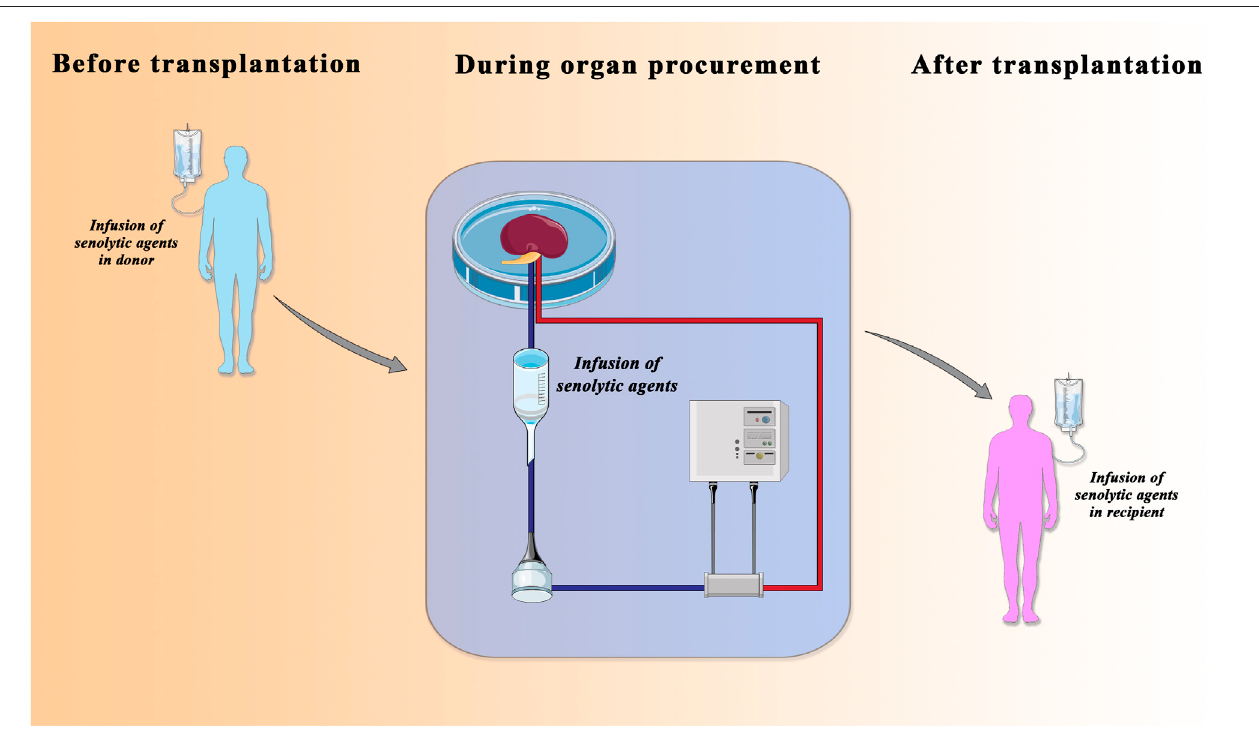
FIGURE 2 | Senolytic agents in transplantation fi eld. The administration of senolytic agents in donor (left) , in normothermic-perfusion device (middle) , and in recipient (right) is considered a therapeutic approach to improve the quality of older donor organs that have traditionally been considered unusable for transplantation. AdaptedfromLauA,KennedyBK,KirklandJL,TulliusSG.Mixingoldandyoung:enhancingrejuvenationandacceleratingaging.JClinInvest.2019Jan2;129(1),4 –